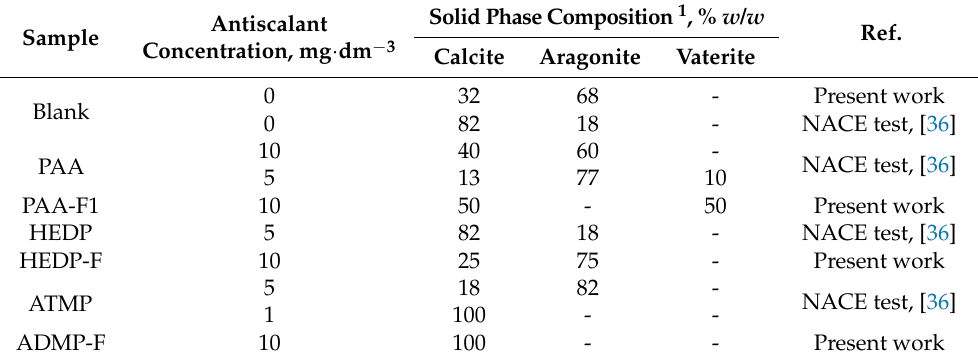
Table 3. XRD calcium carbonate scale characterization